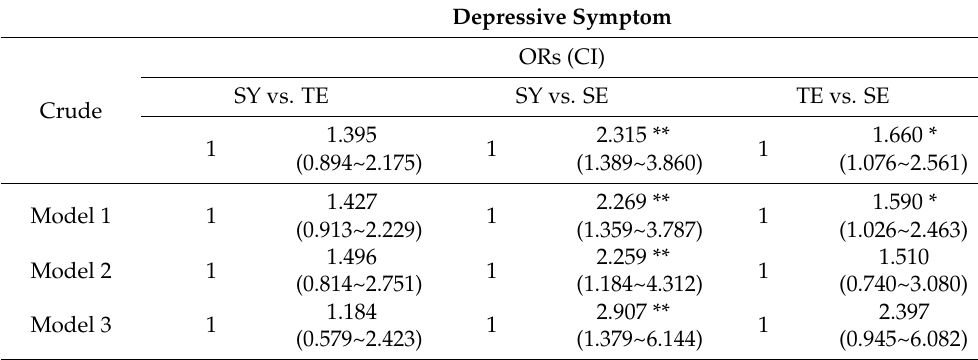
Table 3. Adjusted ORs (95% CI) by Sasang constitution for depressive symptom ( n = 653).